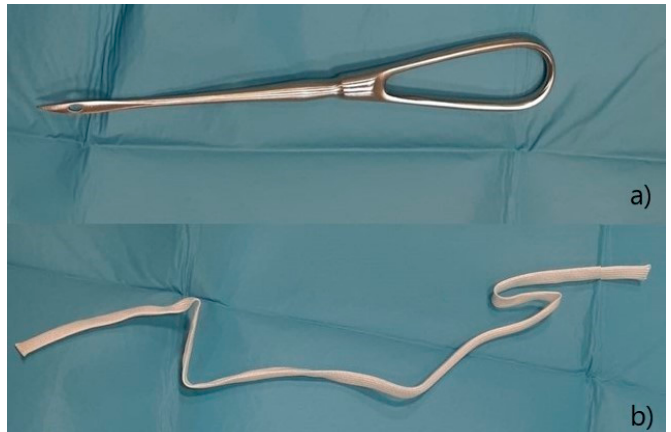
Figure 3 . ( a ) Gerlach needle; ( b ) sterile vaginal tape .